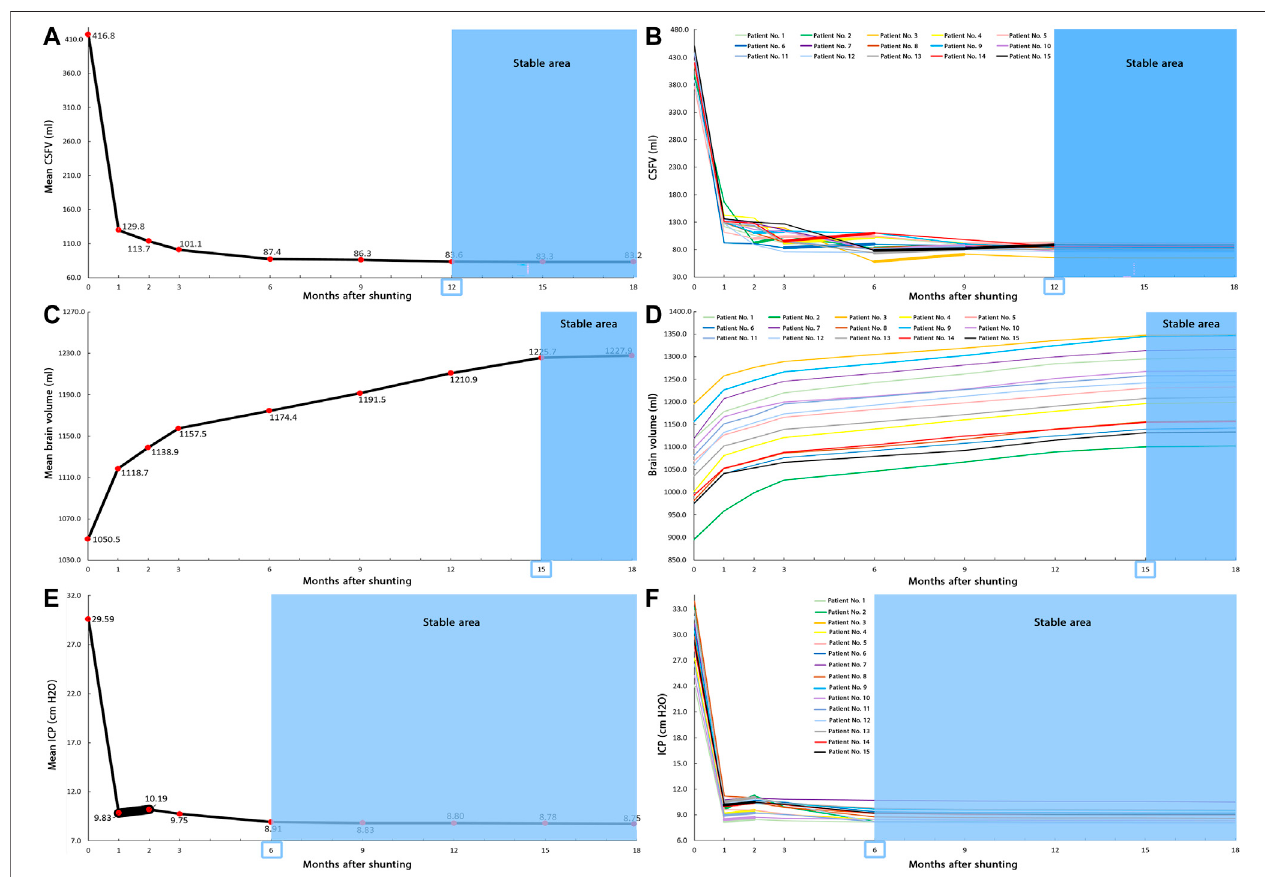
FIGURE3| ChangesofCSFV,brainvolume,andICPover18 monthsaftershunting. (A) The “ meanvalue ” ofCSFVpriortoshuntinguntil18monthsaftershunting. Thedecrease in “ meanvalue ” ofCSFVfrom priortoshuntingto18 months aftershuntingwas80.0%. (B) CSFVchangedin15patients priortoshuntinguntil18months aftershunting.Betweenthethirdand12thmonths,patientshadsomeincreasesinCSFV.After12 months,CSFVreachedastablecondition. (C) The “ meanvalue ” ofthe brain volume prior to shunting until 18 months after shunting. The increase in “ mean value ” of the brain volume from prior to shunting to 18 months after shunting was 16.9%. (D) The brain volume changes of 15 patients prior to shunting until 18 months after shunting. In all steps, there was an increase in the brain volume of all patients. After 15 months, the brain volume reached a stable condition. (E) The “ mean value ” of ICP prior to shunting until 18 months after shunting. The decrease in “ meanvalue ” ofICPfrom priortoshuntingto18months after shuntingwas70.4%. (F) ICP changesof15patients priortoshuntinguntil18 months after shunting.Inthe second month, 12 patients had an increase in ICP value. After 6 months, ICP reached a stable condition. The bold lines indicate the ascending trend, and blue areas show the stable areas of CSFV, brain volume, and ICP changes. Raw data for Figures 2A – C are included in Supplementary Tables S1, S2, and S3 , respectively. CSFV: cerebrospinal fl uid volume; and ICP: intracranial pressure.